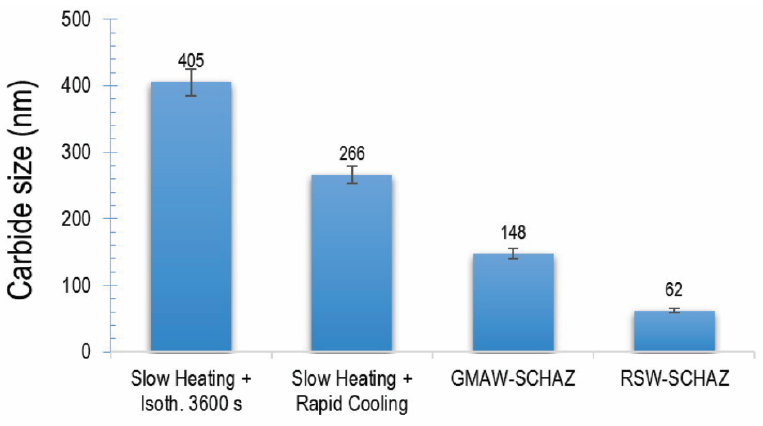
Figure 8. Carbide size in tempered martensite islands upon different conditions.